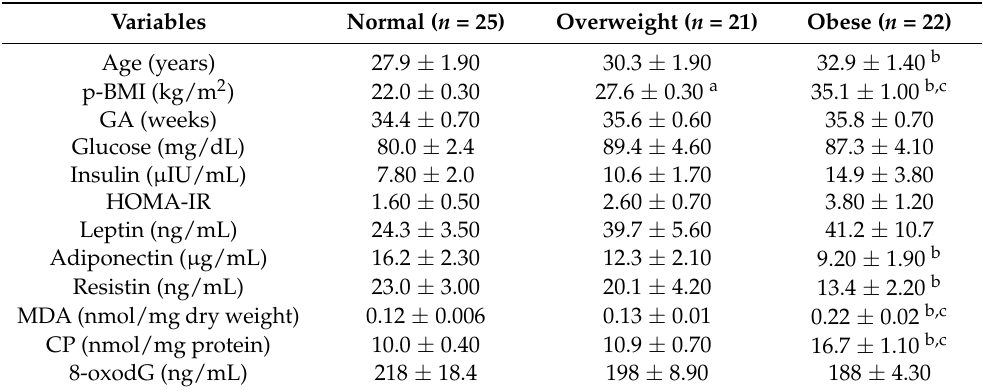
carbonylated proteins; 8-oxodG: 8-hydroxy-2 ′ -deoxyguanosine. Values represent mean ± SEM (Standard Error of the Mean). p values were estimated using one-way ANOVA with DMS post hoc test. a p < 0.05 overweight versus normal; b p < 0.05 obese versus normal; c p < 0.05 obese versus overweight.